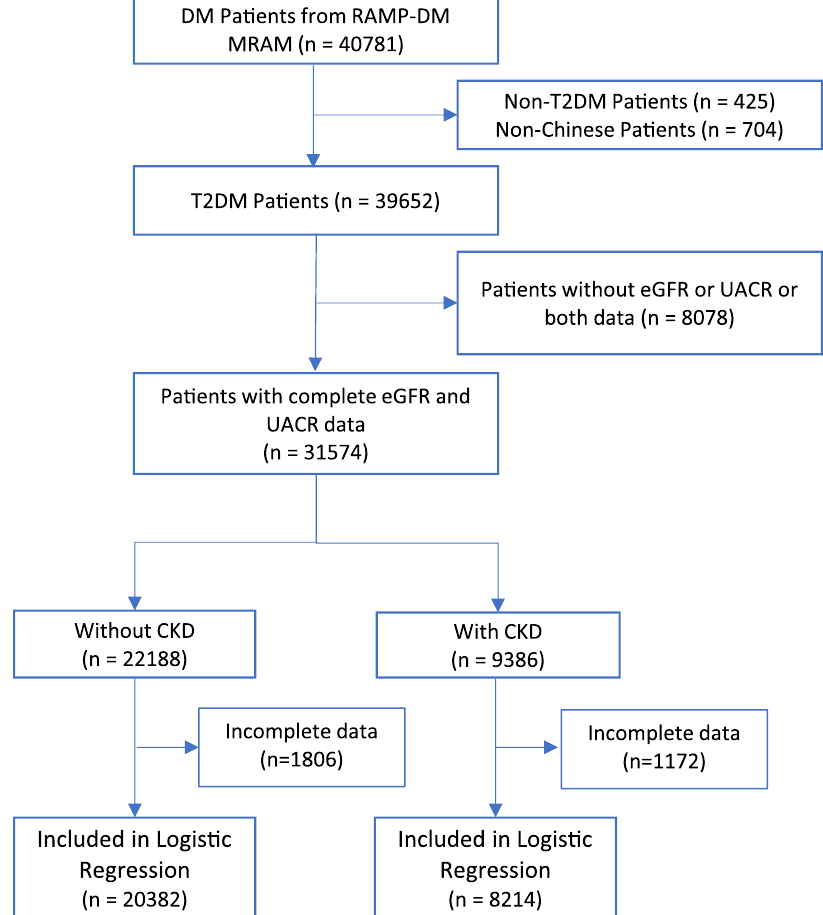
Figure 1. Flow chart of data extraction and analysis. Incomplete data refer to missing in at least one of the following variables: sex, age, DM duration, education, smoking, alcohol drinking, SBP, DBP, hypertension, BMI categories, CHD, stroke, PAD, DR status, HbA1c, HDL-C, LDL-C, TG, receiving